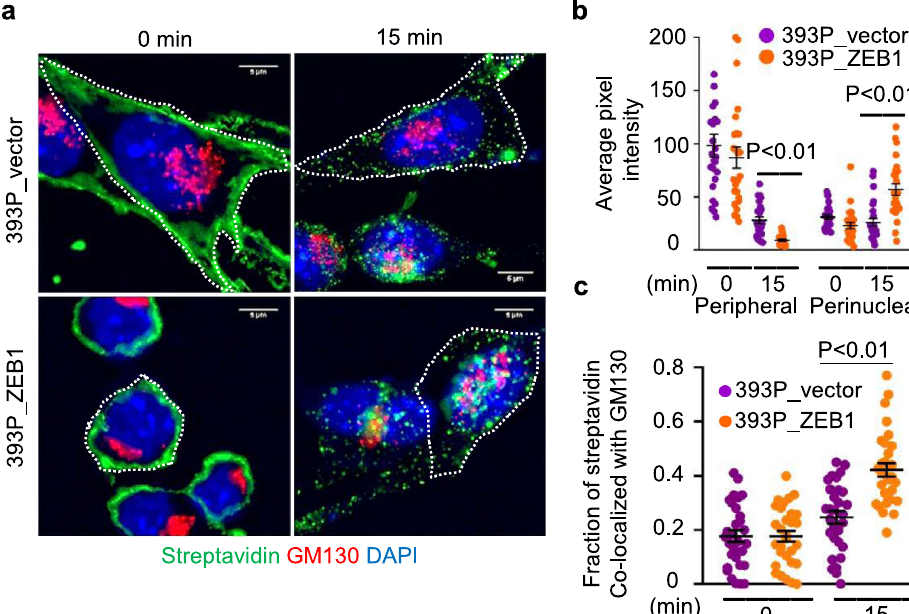
Fig. 1 ZEB1 enhances the endocytosis of PM-bound proteins. a Merged confocal micrographs taken before ( T = 0) and 15 min after initiating endocytosis of labeled biotin. Cells treated with Alexa-488 labeled streptavidin and stained with anti-GM130 to detect endocytosed biotin and Golgi, respectively. Cells are outlined (dashed lines). Scale bars: 5 µ m. b Biotin signal intensities in perinuclear and peripheral compartments in each cell (dot). Values represent maximal signal intensities in each cell. n = 25 cells from 3 independent experiments. c Fractions of total biotinylated proteins that colocalized with GM130 at each time point. n = 30 cells from 3 independent experiments. Data are presented as mean values ± SEM; P values, two-tailed Student ’ s t